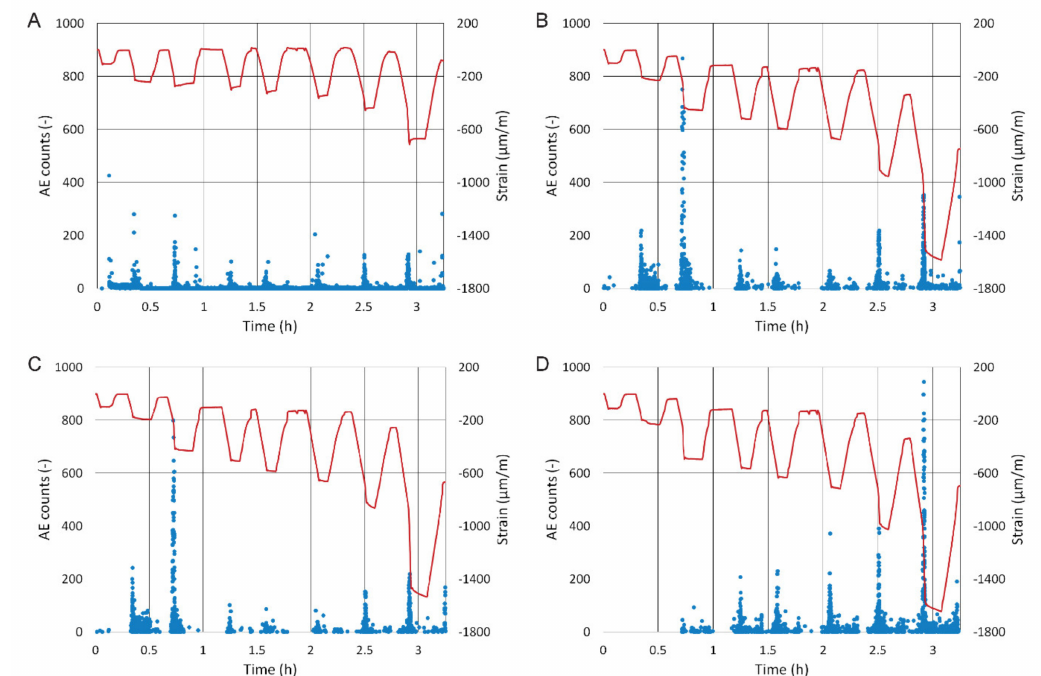
Figure 6. AE counts and development of relative strain in each tile ( A ) material system A, ( B ) material system B, ( C ) material system C and ( D ) material system D.